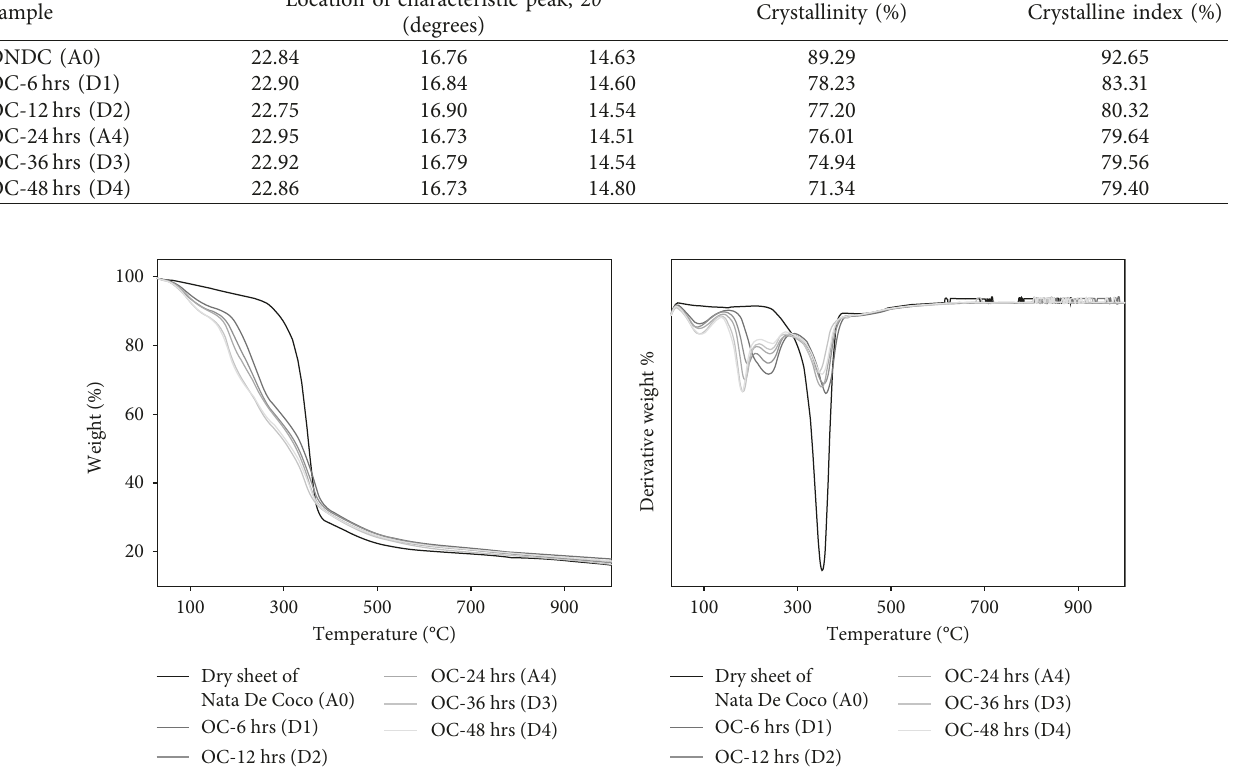
Table 2: Characteristic peaks and crystalline parameters of DNDC (A0) and the OC products. Location of characteristic peak, 2 θ Sample